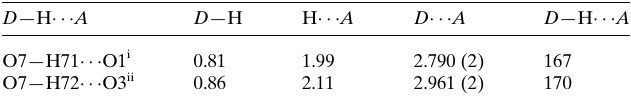
Table 3 Hydrogen-bond geometry (A˚ , (cid:5) ) for (II).